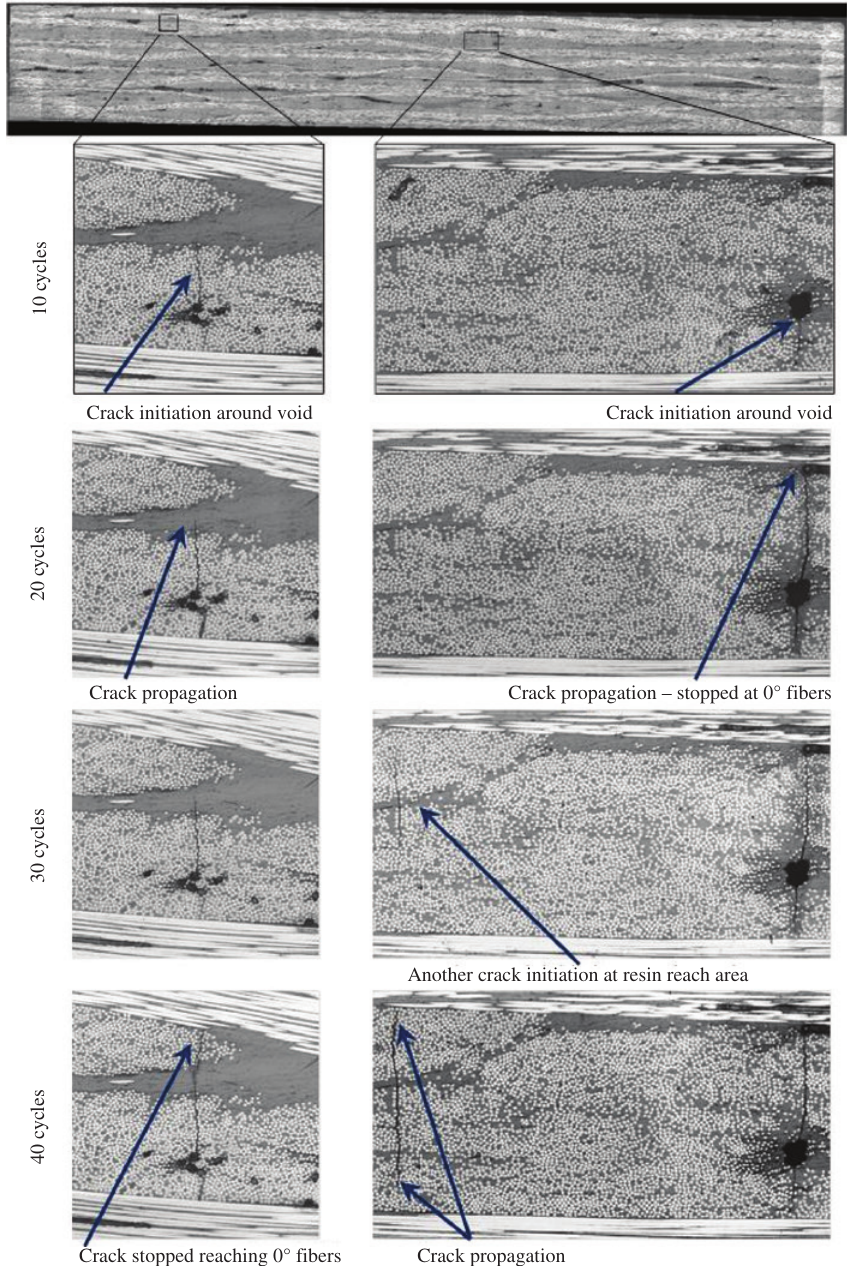
Figure 3: Optical microscopy image of the cross-ply fabric laminate after several thermal cycles. Crack imitation and propagation around the void within tows and at resin-rich areas are demonstrated after 10, 20, 30 and 40 thermal